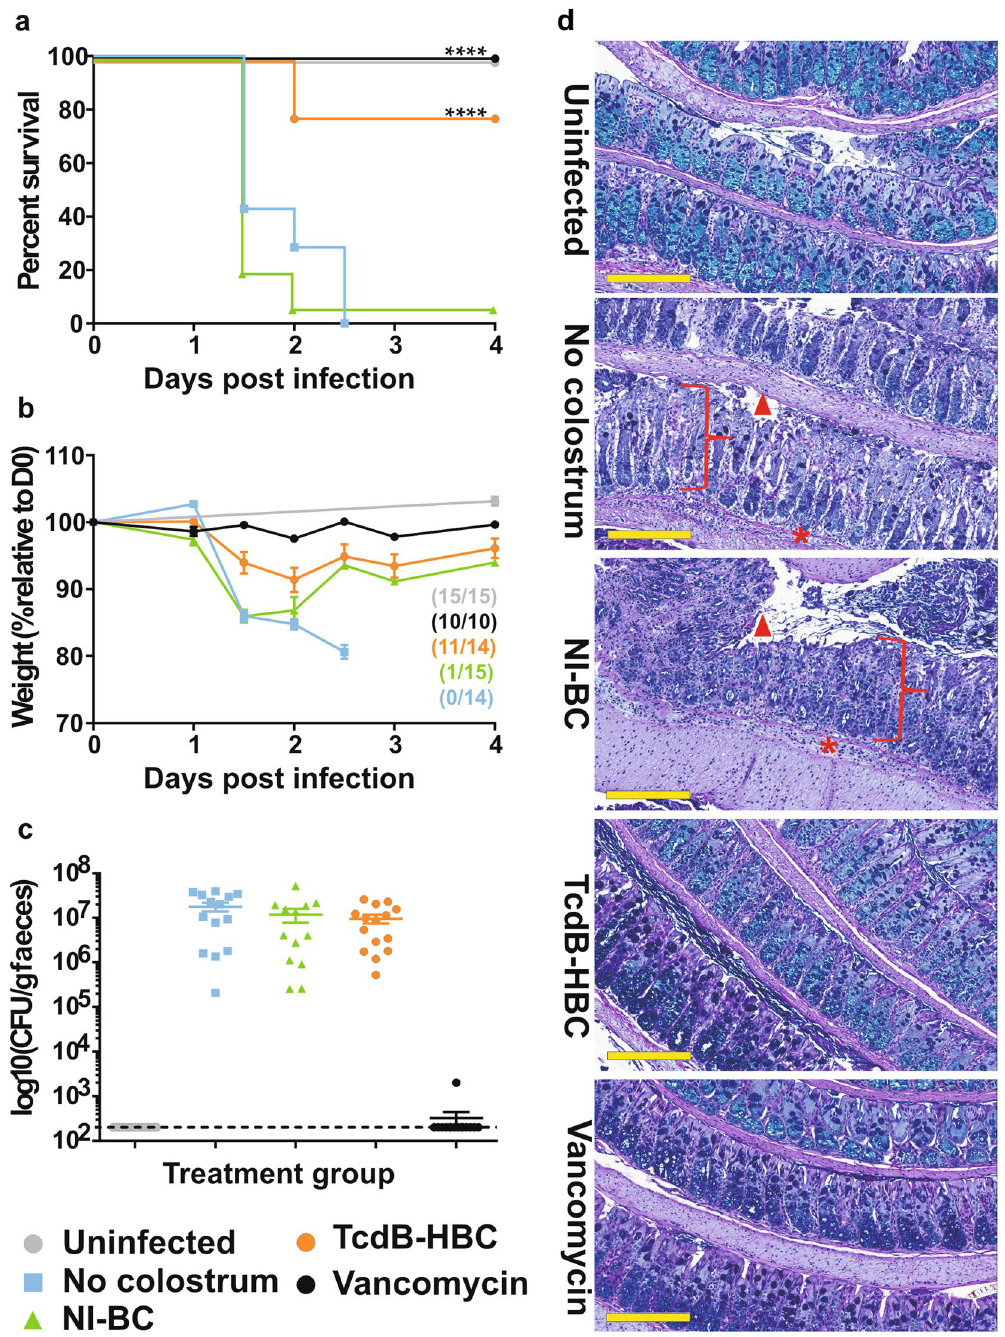
Figure 3. HBC-mediated treatment of C. difficile -infected mice. Mice were uninfected or infected with C. difficile spores and treated six hours post-infection with NI-BC, TcdB-HBC, vancomycin or were untreated. Mice were monitored daily for survival ( a ) and weight loss ( b ). Weight loss is presented as the % weight relative to the day of infection (day 0 or D0). Numbers in brackets indicate the number of surviving mice at the completion of the experiment compared to (/) the total number of mice at the beginning of the experiment. Faecal spore load was determined 24 hours post-infection and is presented as CFU/gram faeces (log 10 ), with each point representing a single mouse ( c ). The limit of detection is represented as a dotted line. Error bars represent the mean ± SEM of n = 10–15 mice. **** Indicates P < 0.0001. Representative images of PAS/Alcian blue stained colonic ( d ) tissue from mice. Square brackets ([) indicate crypt hyperplasia, arrow heads ( ▲ ) represent epithelial damage and asterisks ( * ) represent oedema and inflammation. Scale bars represent 200 µ